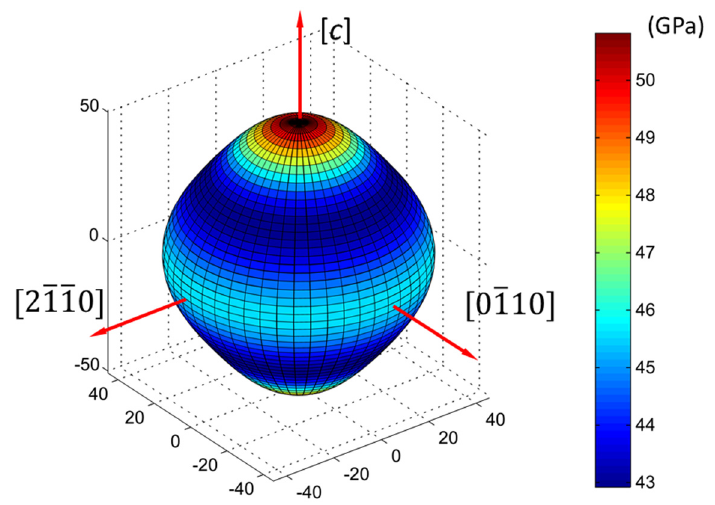
Figure A1. 3D plot of the directional dependence of the Young’s modulus of Mg. Table A1. Calculated stress ratio (cid:2018) between the active (in CD) and reaction (in TD) stress compo ‐ nents of the biaxial stress state in channel ‐ die compression for various tested single crystal orienta ‐ tions and the Euler angles de fi ning the basal fi ber for which the respective (cid:2018) ratio is constant. Single Crystal Orientation